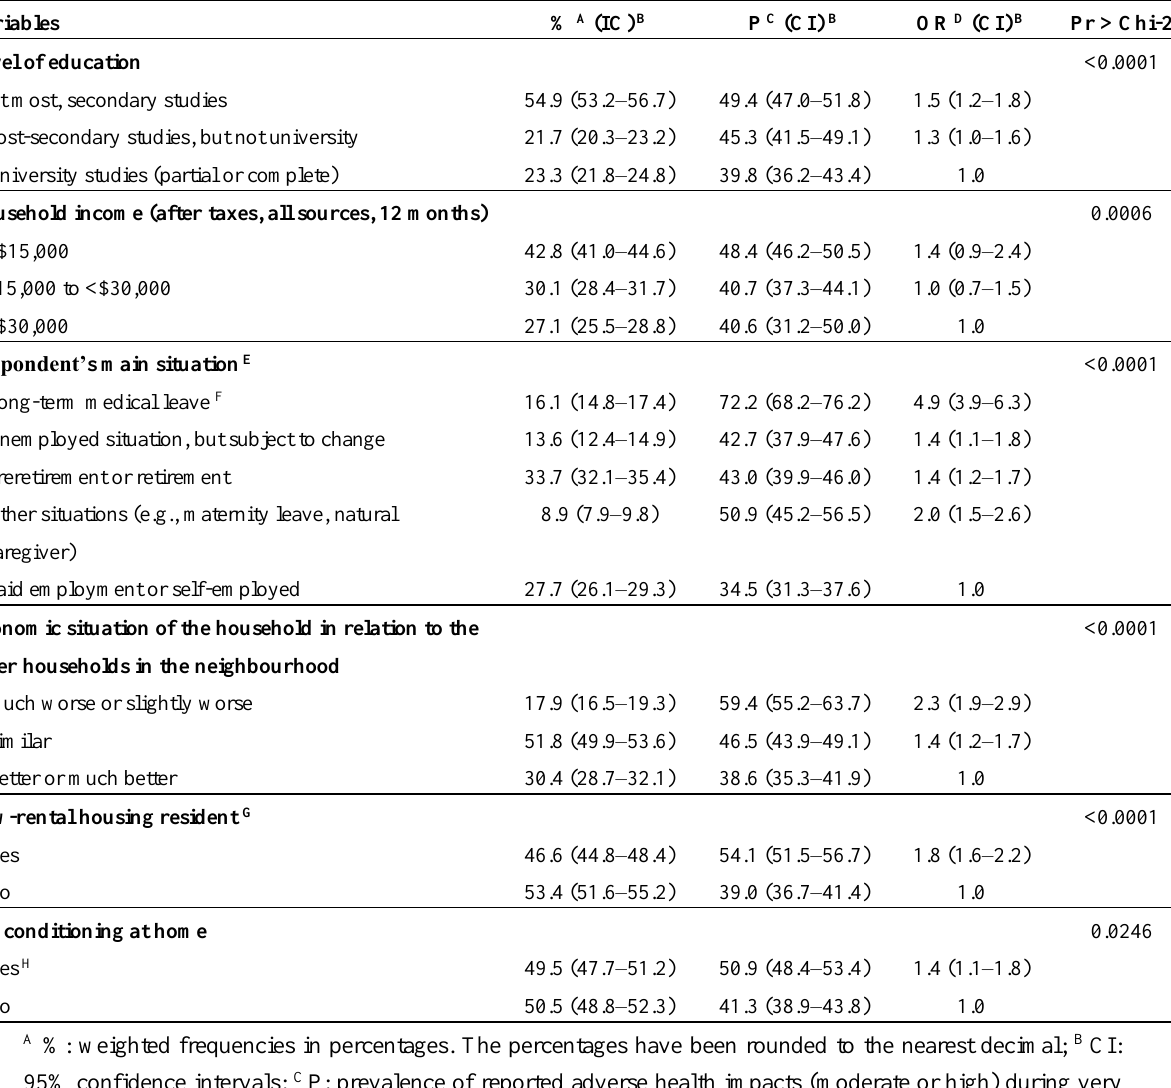
Table 2. Prevalence of reported adverse health impacts, very hot and humid summer conditions, based on socioeconomic